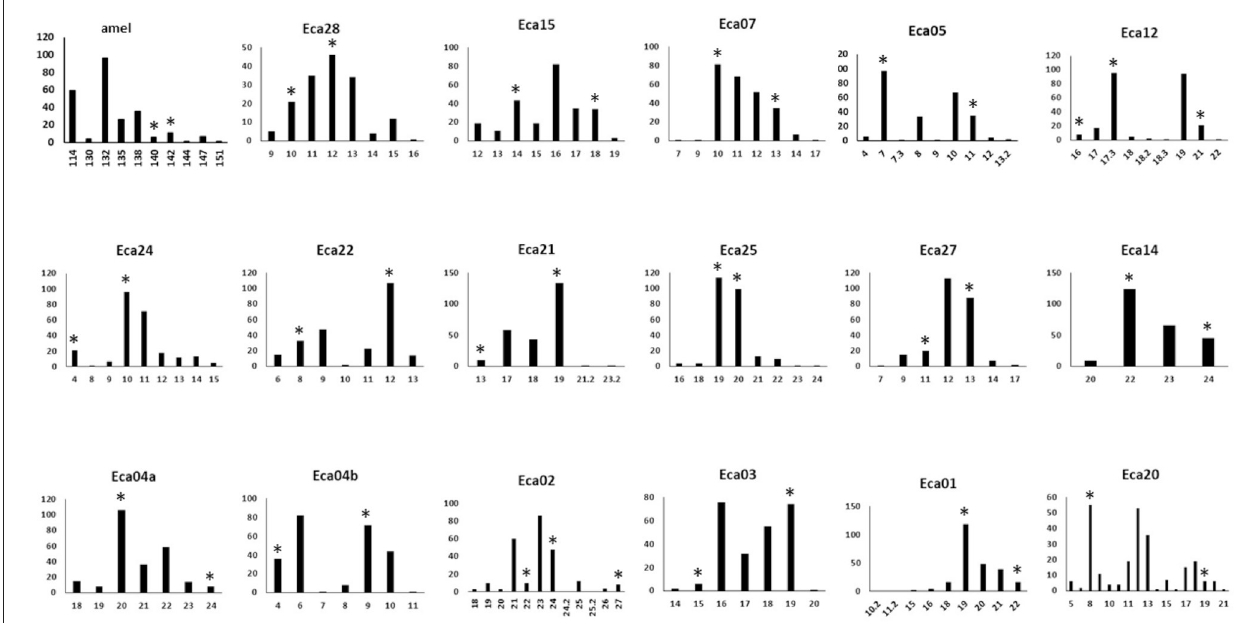
FIGURE 1 | Histograms of allele frequencies for markers across 124 horses with the 17-plex panel plus the amel marker. Allele numbers are on the X-axis and the allele count is given on the Y-axis. Asterisks indicate the alleles that were Sanger sequenced (Genbank MN646783, MN684168, MN684204). The markers are displayed in the order of the color of the fluorescent label used (FAM, NED, PET), and size order, as is the case in Table 1